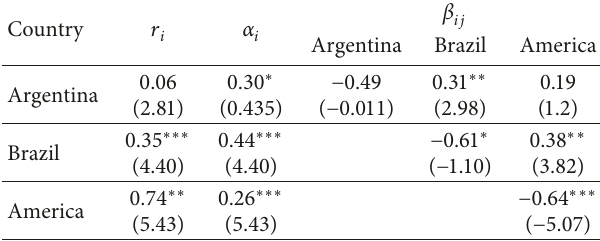
Table 2: Estimation results of model parameters.